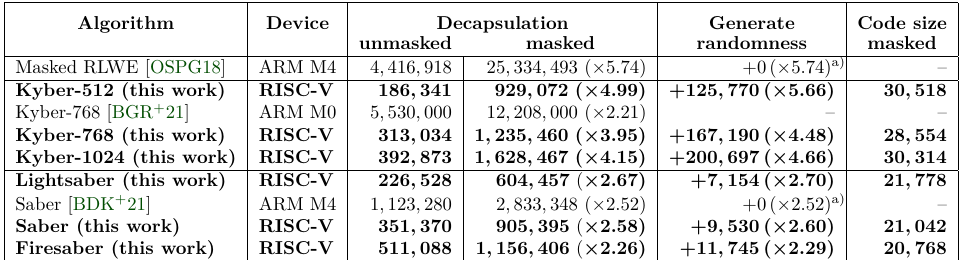
Table 8: Cycle count and code size in bytes masked ( -O3 , GCC PULPino RISC-V compiler 7.1.1